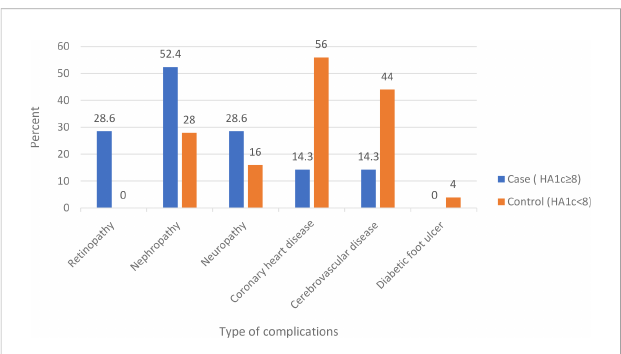
FIGURE 1 Complications among type 2 diabetes mellitus patients at DM clinic of UoGCSH, Northwest Ethiopia, 2020.